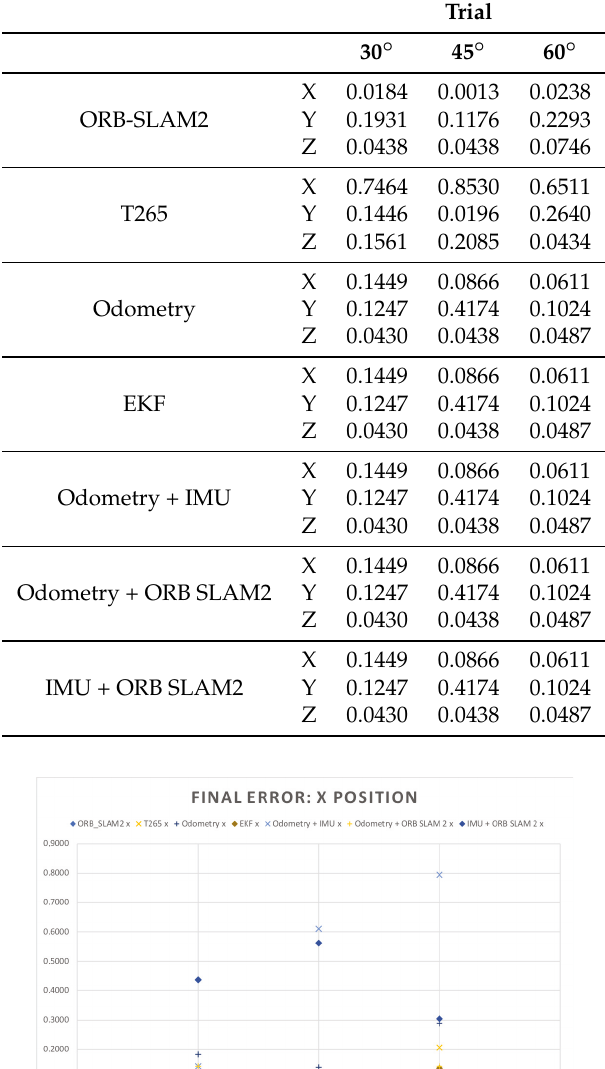
Table 8. Results for the indoor scenario 2 test 2: Walking with different ground sweep angle.